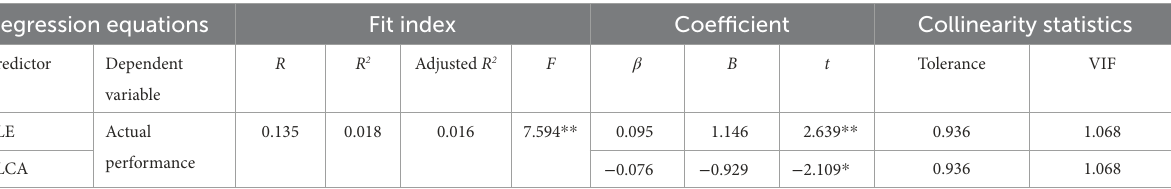
TABLE 5 Regression analysis with three emotions as predictors of actual performance.